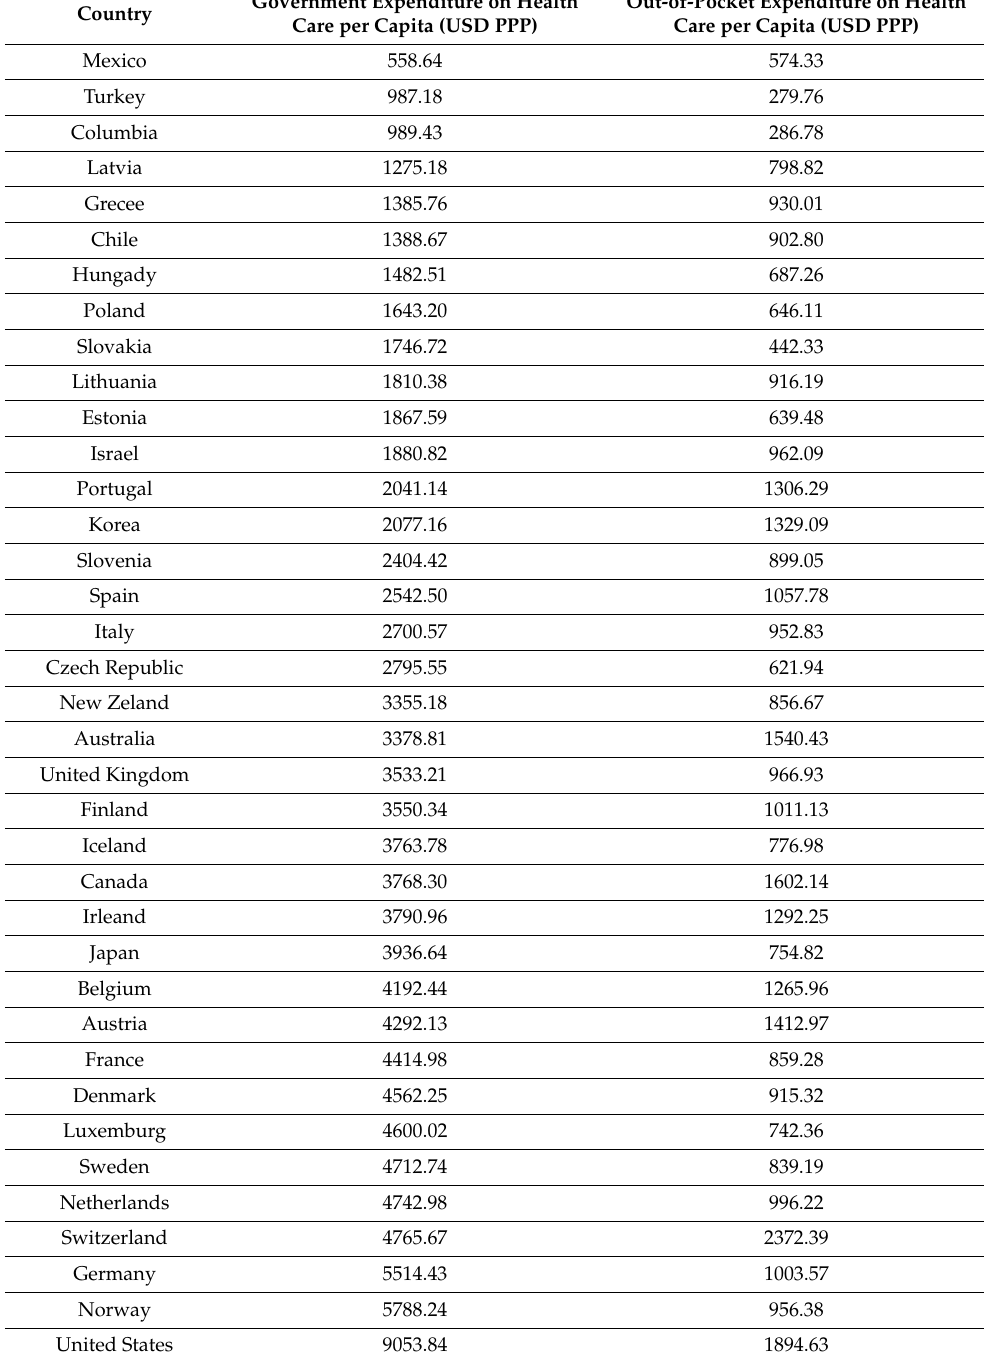
Table 1. Health care expenditure by type in selected OECD countries in 2019